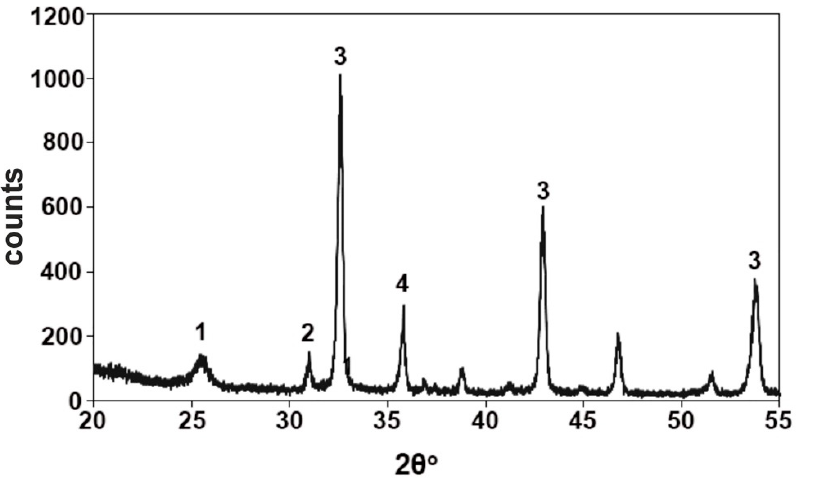
Figure 3. XRD pattern of magnesite tailing from Evoia. 1: quartz, 2: dolomite, 3: magnesite, 4: ser- pentine.